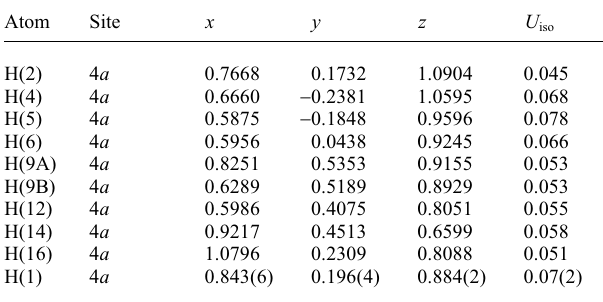
Table 2. Atomic coordinates and displacement parameters (in Å 2 )